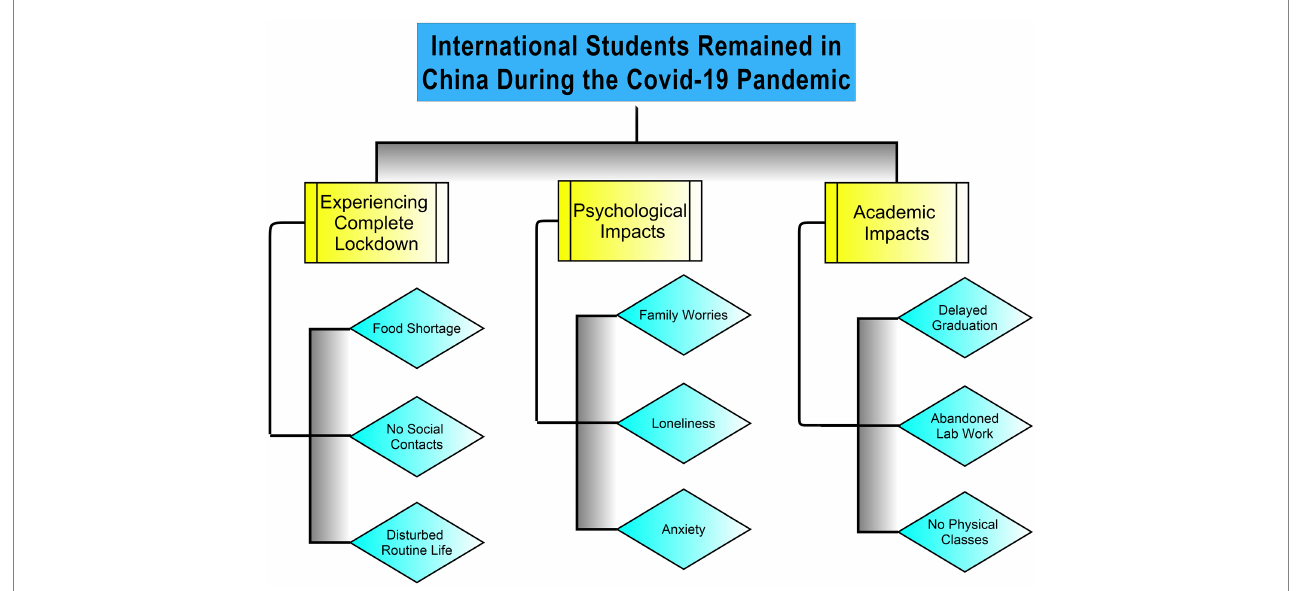
FIGURE 1 Schematize representation of themes regarding International students who remained in China during the